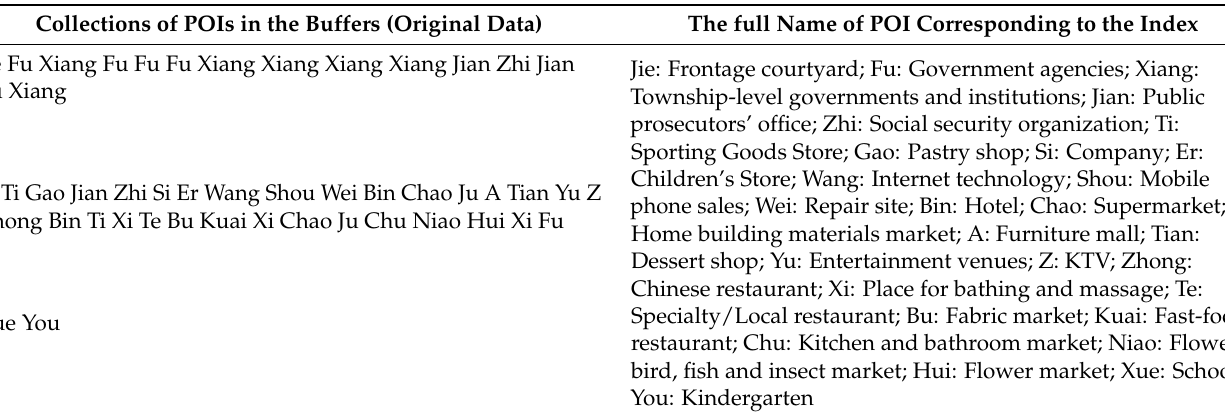
Table 1. Examples of urban functional